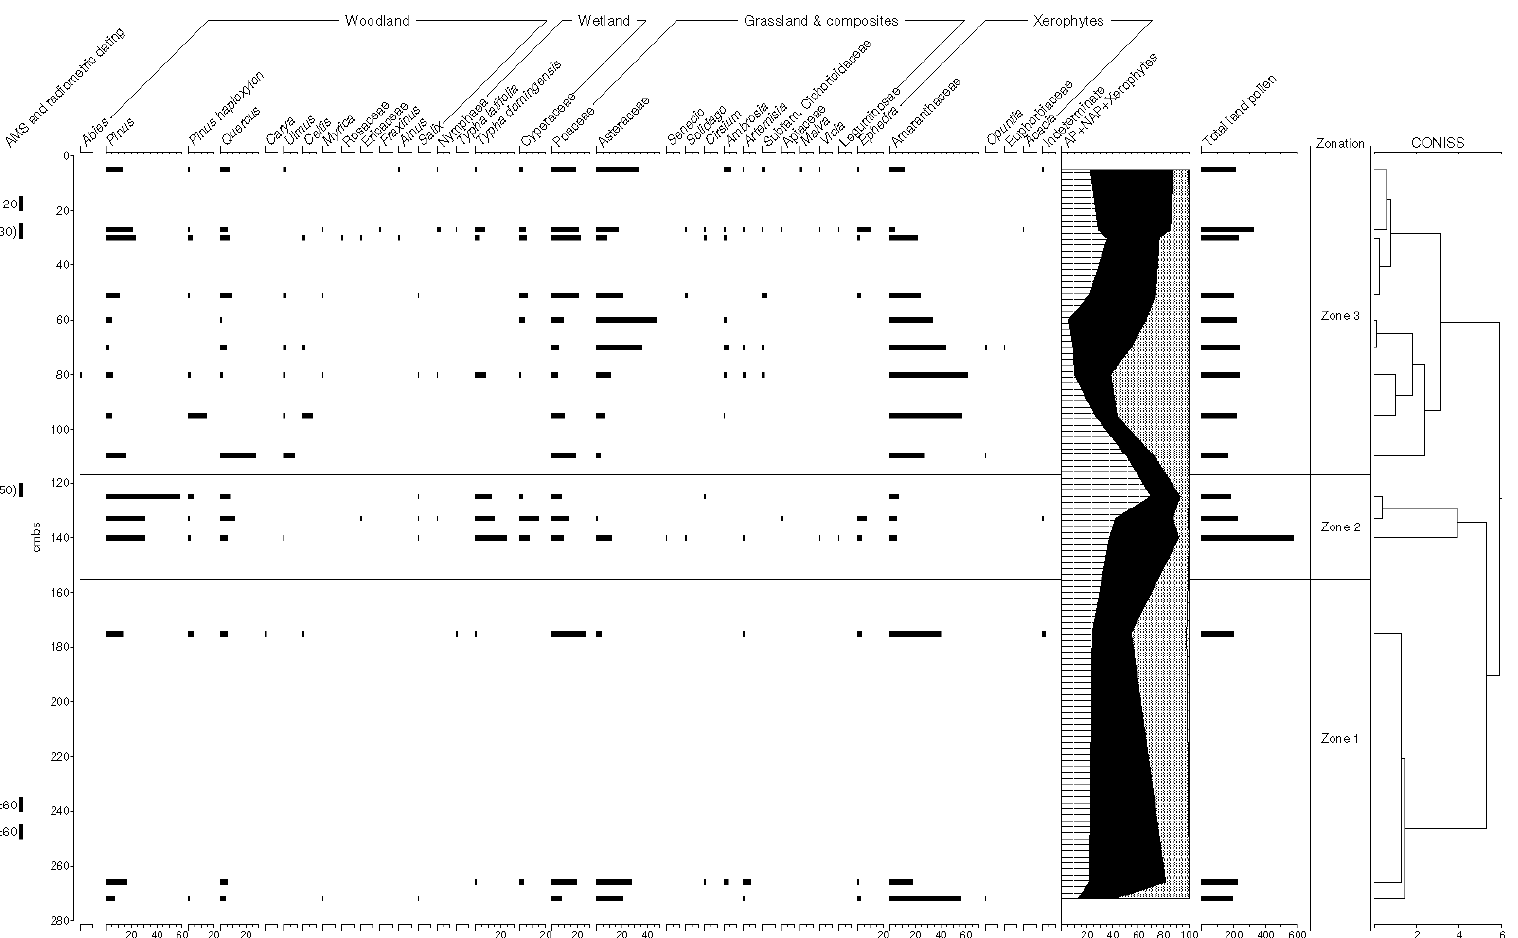
Figure 10. Relative pollen diagram, Upper Arroyo tributary sequence.